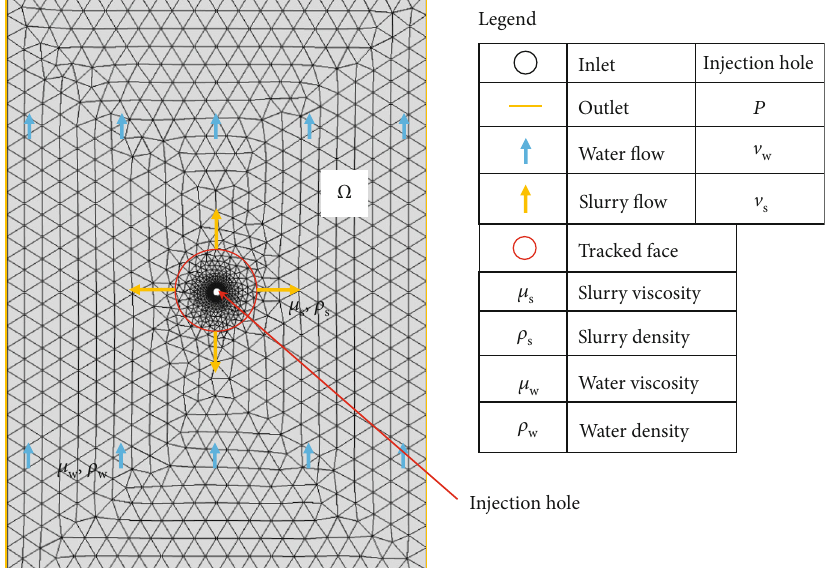
Figure 5: Calculation model.